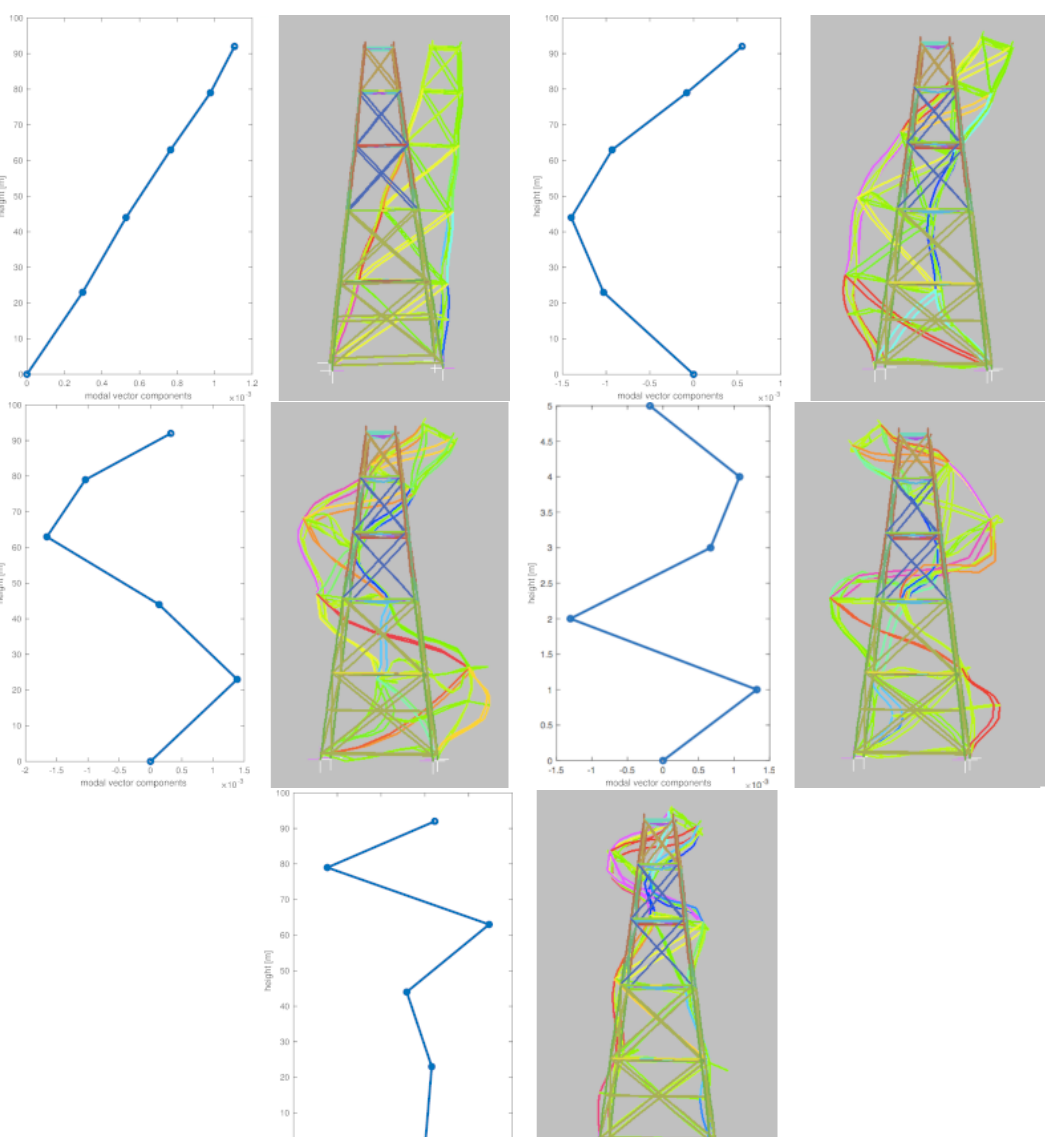
Figure 2. Mode shape comparison between 5DOF and the FE